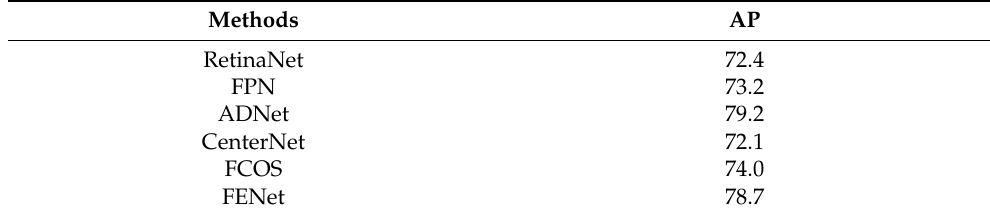
Table 5. Detection results of different